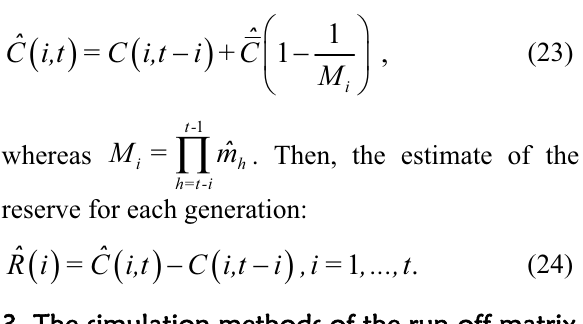
(j = 0 , 1 , …, t (cid:16) 1 ) j